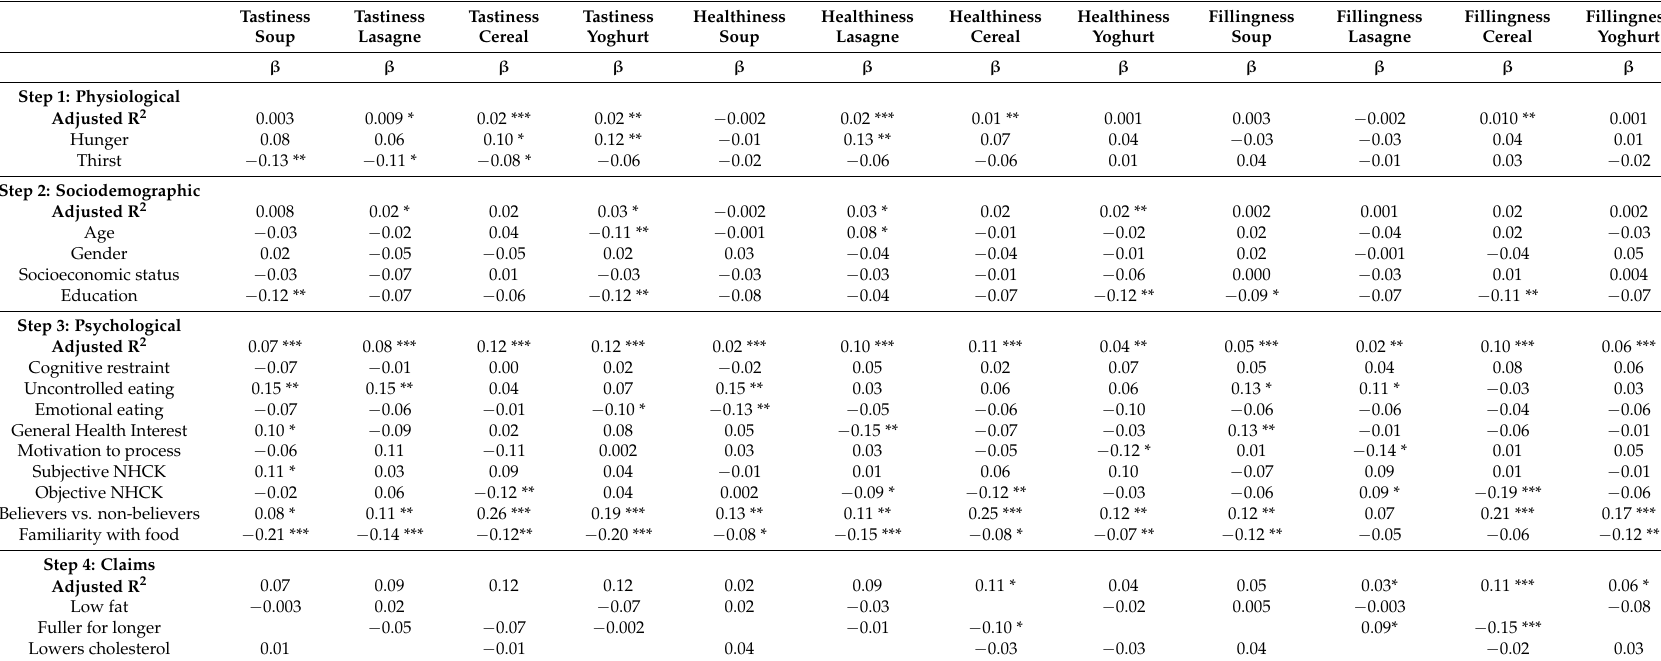
Table 2. Explained adjusted variance and standardized coefficients ( β ) for each regression for perceptions after the addition of each